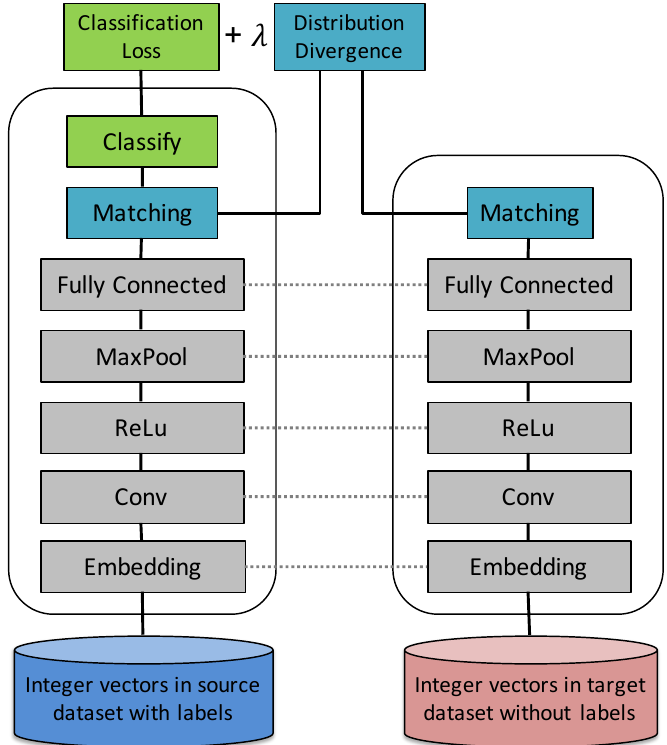
Figure 3. Our model considers both classification loss, as well as data distribution